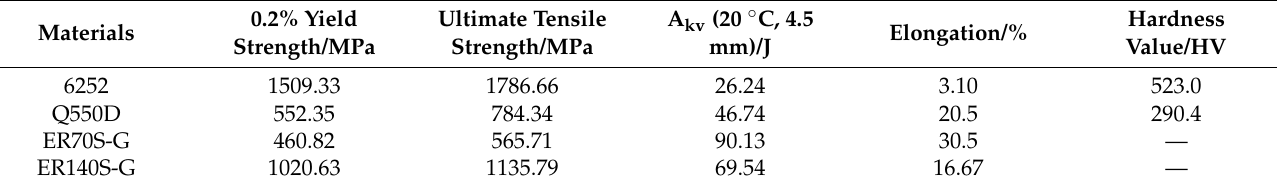
Table 2. Mechanical properties of the welding materials.